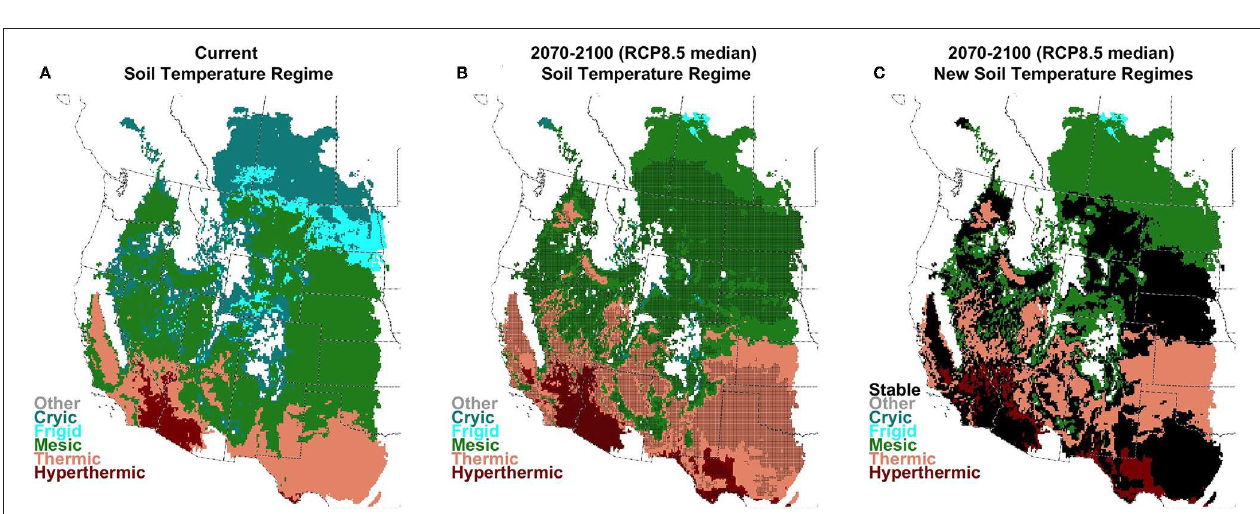
regimes expanded in the southern and middle portion of the study area, at the expense of the Mesic regime, which shifted northward. Soil Moisture Overall Aridity Aridic soil moisture regimes are distinguished from other regimes by DRY PROP > 50%, where DRY PROP is the proportion of warm days (T 50 > 5) that have entirely dry soils (warm and dry days divided by total warm days; Figure 2 ). For the median GCM, we found that future climate conditions promoted increases on average in both the number of warm days ( Figure S1.7 ) and the number of warm and dry days ( Figure S1.8 ). Near-term projections for the median GCM suggest an increase of 16 warm days for RCP8.5 (10–90% of GCMs: 9–26 days) and 14 days for RCP4.5 (6–22 days). Long-term projections indicated 45